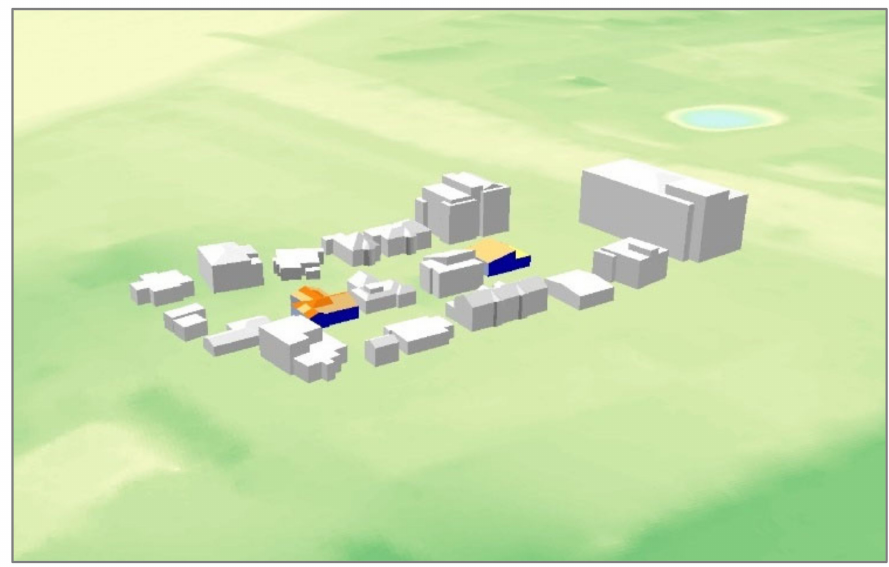
Figure 6. Example of representation of the shadow panel